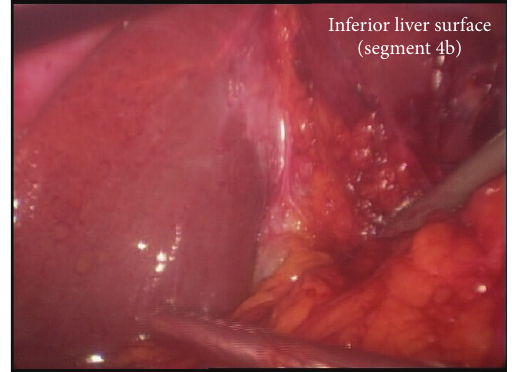
Figure 2: Dense adhesions occupy the gallbladder bed precluding clear visualization of anatomy.